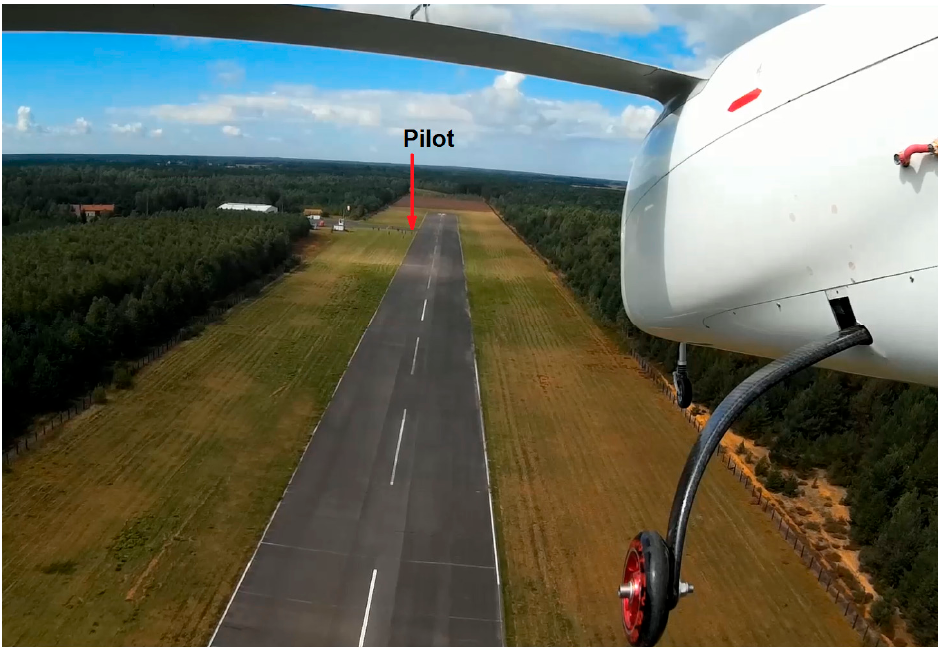
Figure 6. Picture taken from the demonstrator during the approach for landing after the first flight. Distance between the pilot and the airplane was at this point close to the furthest distance that occurred during the whole flight test program.